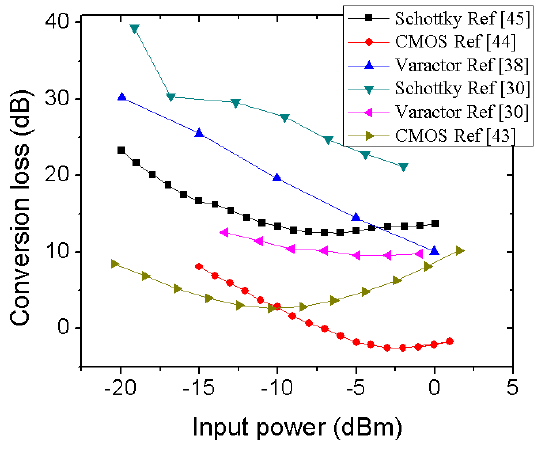
Figure 4. Conversion gain of harmonic generation using different